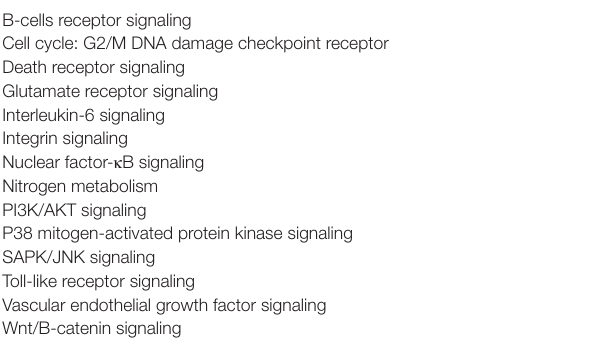
TAbLe 3 | Signaling pathways involved in the development of mucositis